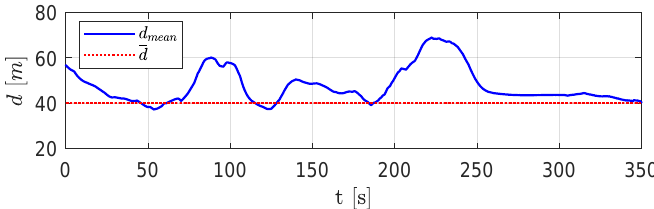
Figure 24. Scenario #2—10 aircraft: mean distance between visible aircraft (blue solid line) compared with desired distance (red dotted line).